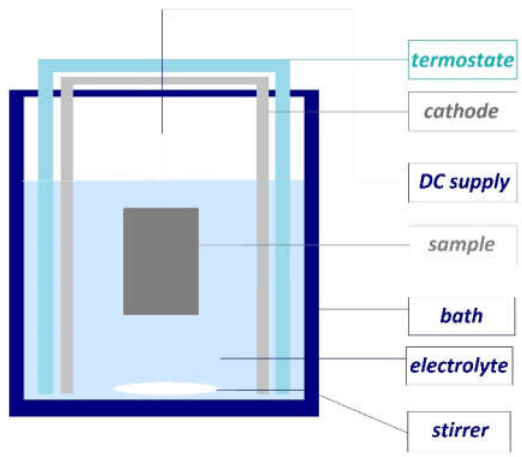
Figure 2. The schematics of anodizing equipment .